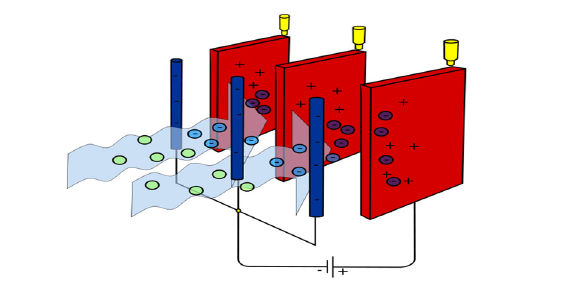
Fig. 3. ESP electrodes and plates